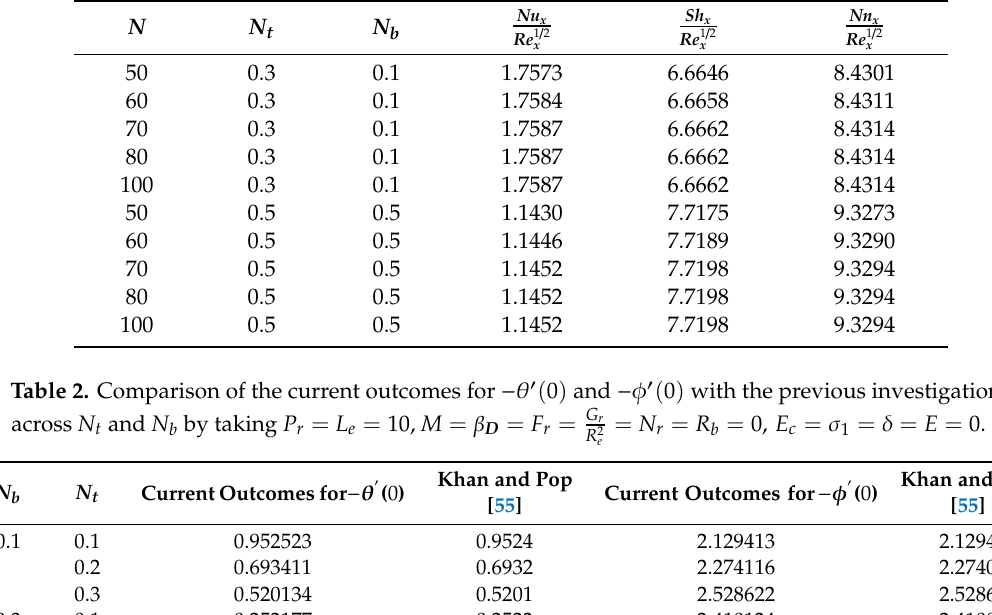
Table 1. Numerical convergent values of Nusselt number, Sherwood Number, and the local density number of the motile microorganisms across N , N t and N b by fixing M = 1, β D = F r = E c = σ 1 = δ =